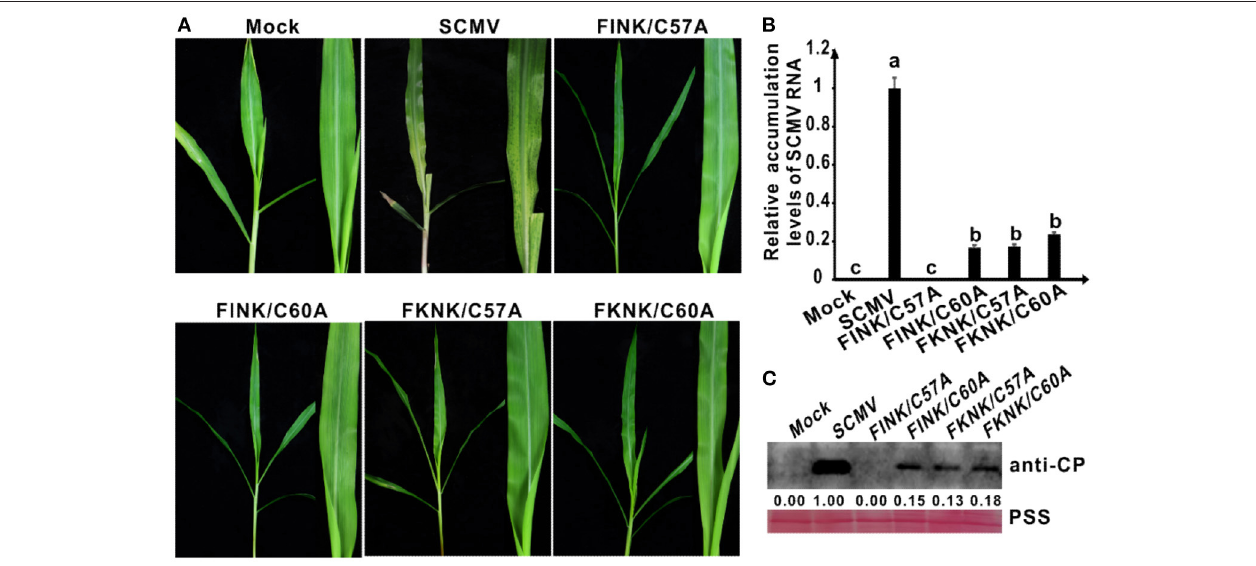
FIGURE 3 | Symptoms and accumulation levels of SCMV double-mutants in maize plants. (A) Symptoms of wild-type SCMV and its double-mutants in maize plants at 10 dpi. Mock, the maize plants inoculated with the empty vector pCB301-Rz. SCMV, the maize plants infected with wild-type SCMV. FINK/C60A, the conserved C 60 was mutated to A residues and R 184 was mutated to I residues in SCMV HC-Pro. FKNK/C57A, the conserved C 57 were mutated to A residues and R 184 were mutated to K residues in SCMV HC-Pro. FKNK/C60A, the conserved C 60 was mutated to A residues and R 184 were mutated to K residues in SCMV HC-Pro. (B) The wild-type and mutant SCMV RNA accumulation levels in the upper leaves of maize plants at 10 dpi. (C) Western blotting analysis of the wild type and mutant SCMV accumulation levels in the upper leaves of maize plants at 10 dpi. The ponceau S staining (PSS) shows sample loadings. Band intensities were measured using the ImageJ software. Numbers indicated the accumulation levels of SCMV CP normalized to PSS staining. The experiments were repeated thrice independently. The statistical analyses as